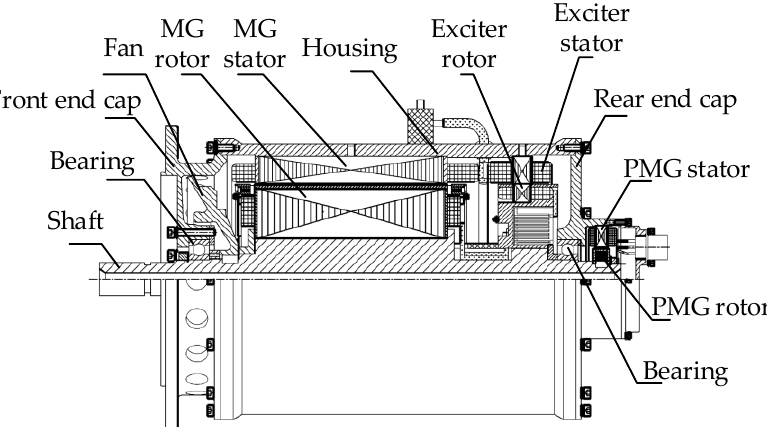
Figure 12. Generator structure diagram.